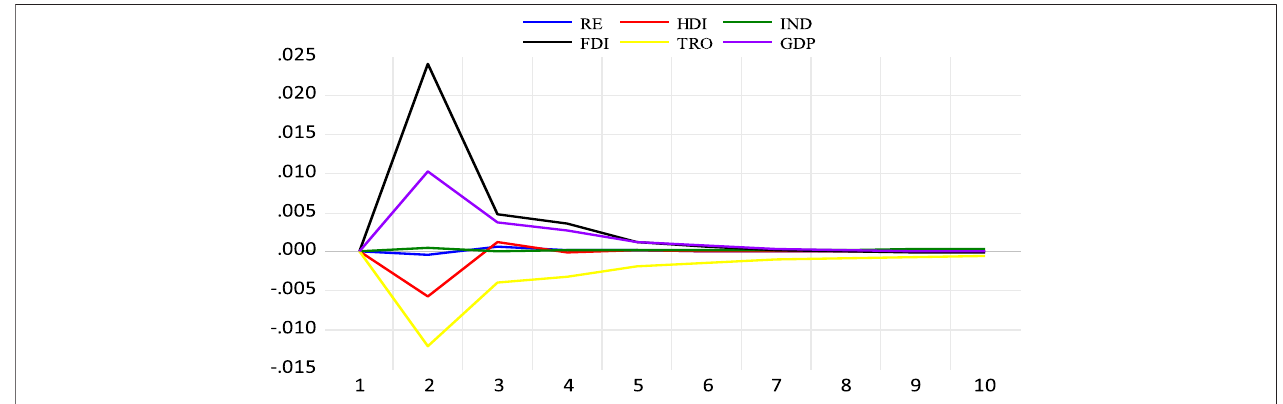
FIGURE 4 | Panel VAR impulse response functions for low-income countries: Reaction of CO 2 emissions (CE) to renewable energy consumption (RE), human development index (HDI), industrialization (IND), foreign direct investment (FDI), trade openness (TRO) and economic growth (GDP) one standard deviation shock.